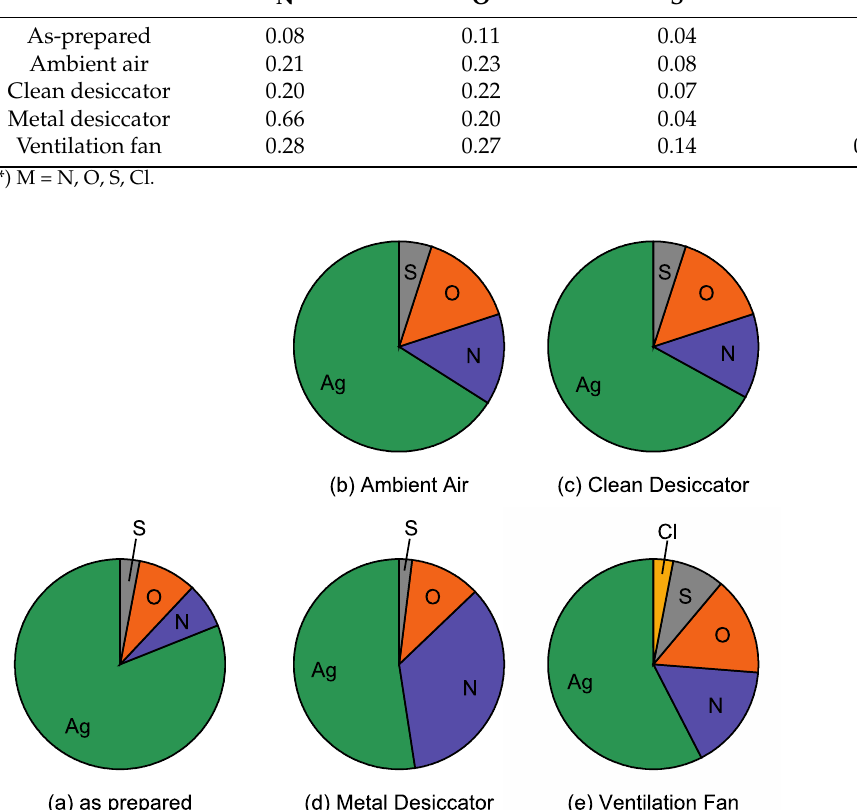
Figure 9. Pie charts showing the atomic ratios of impurity elements onto ( a ) as prepared sample, Ag/HOPG stored ( b ) in ambient air, ( c ) inside the clean desiccator, ( d ) inside the metal desiccator and ( e ) near the ventilation fan for 14 days determined by Rutherford backscattering spectrometry (RBS). Table 1. The atomic ratios of impurity elements M(*) to Ag determined by RBS.